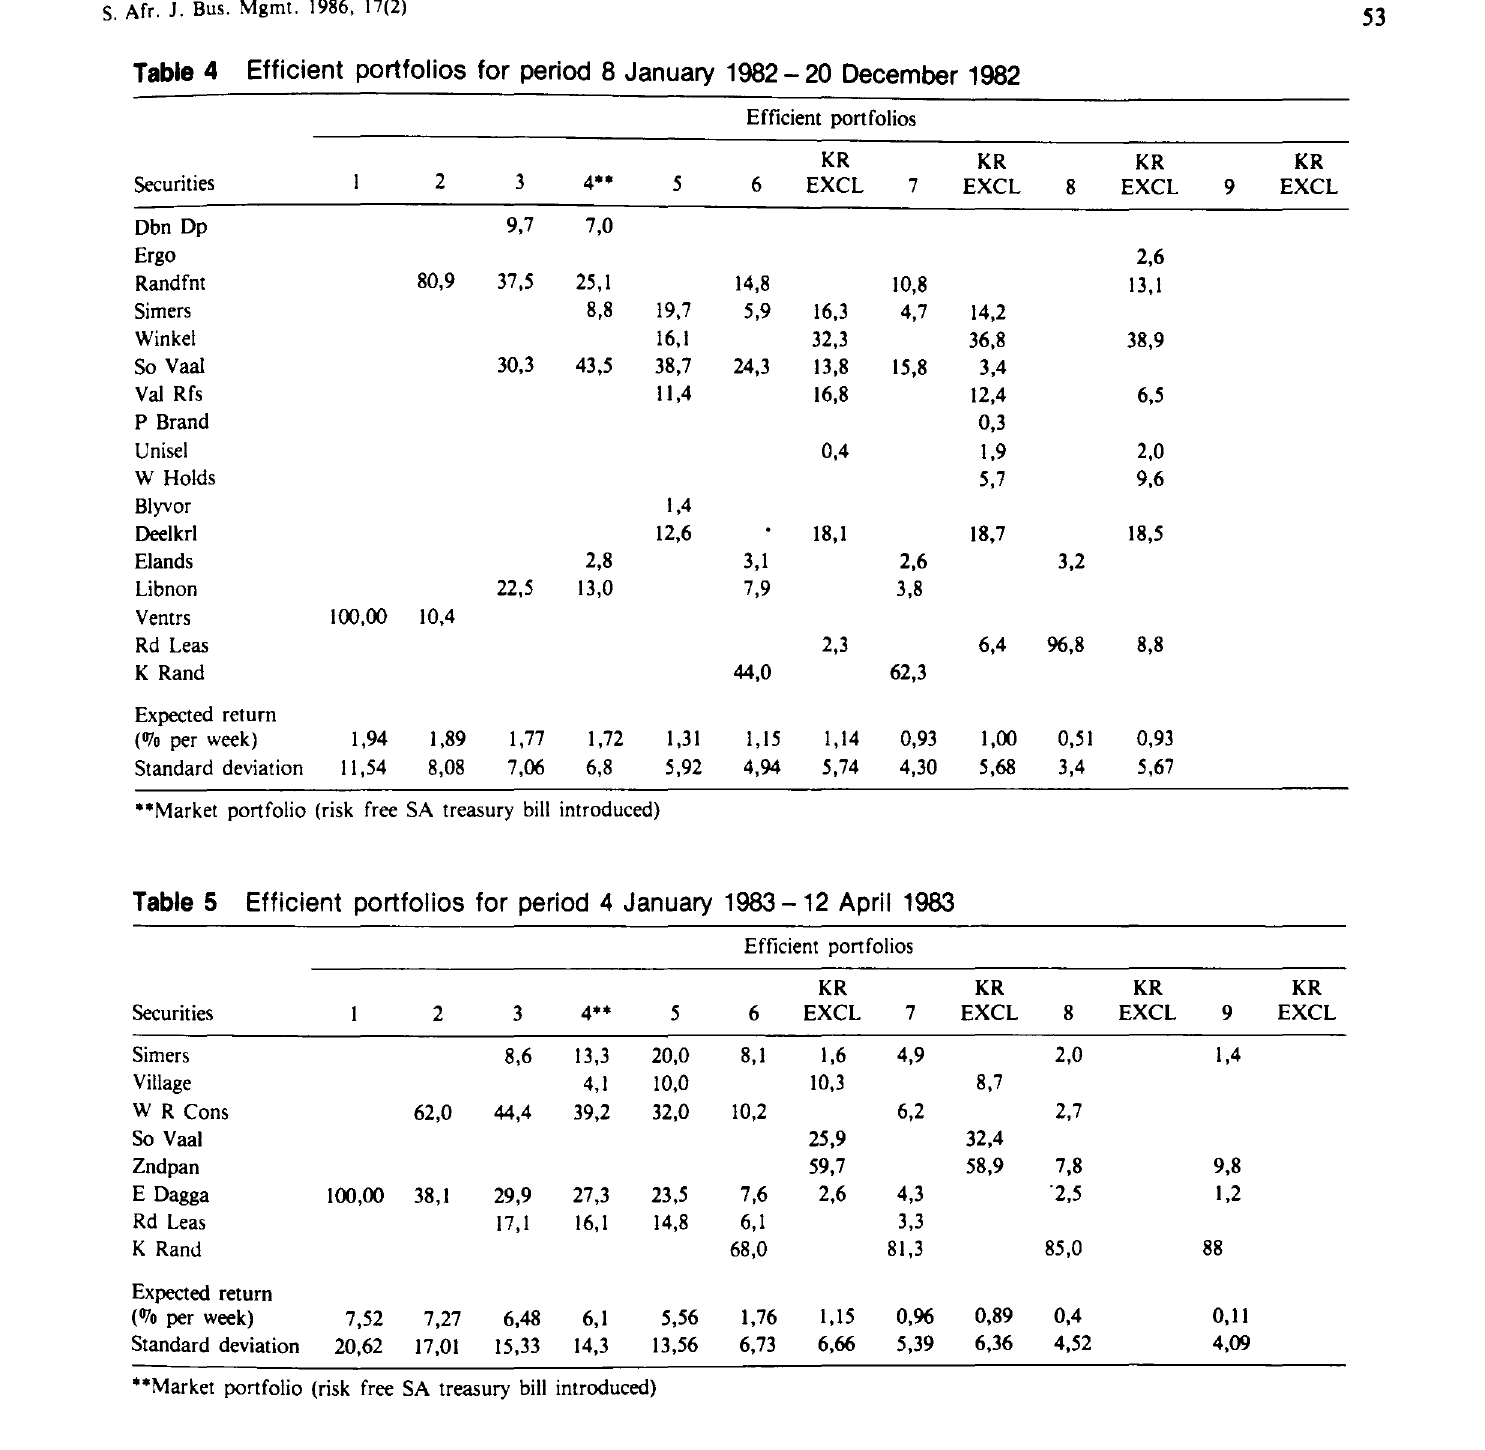
Efficient portfolios for period 4 January 1983-12 April